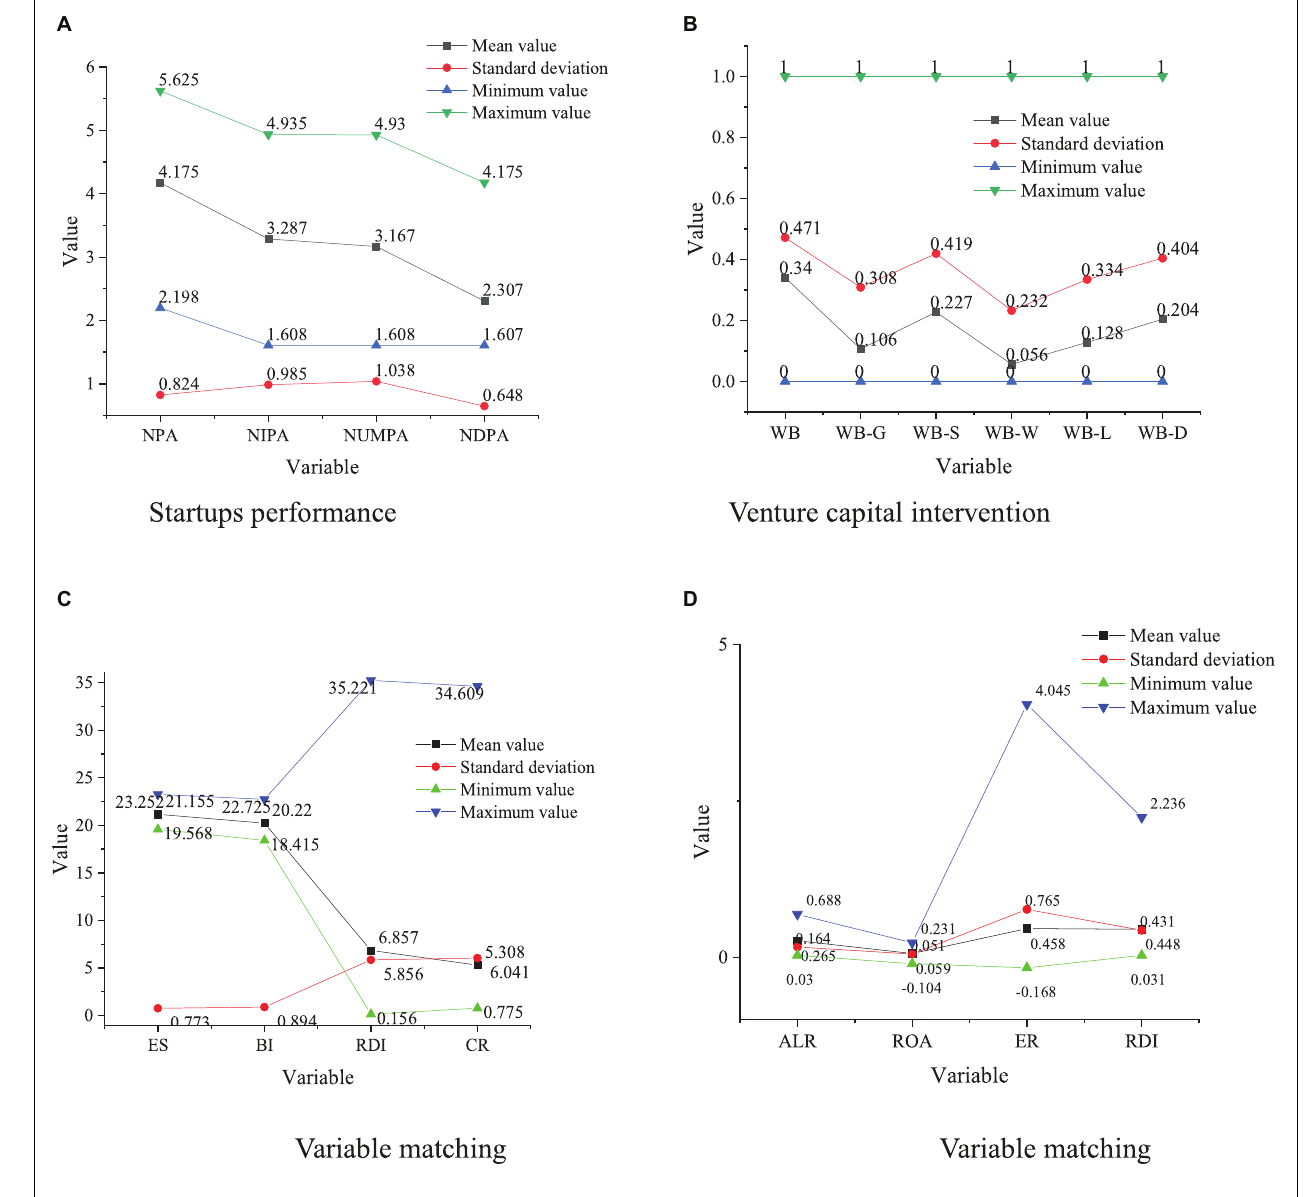
FIGURE 2 | Variable description. (A) Startups performance. (B) Venture capital intervention. (C) Variable matching. (D) Variable